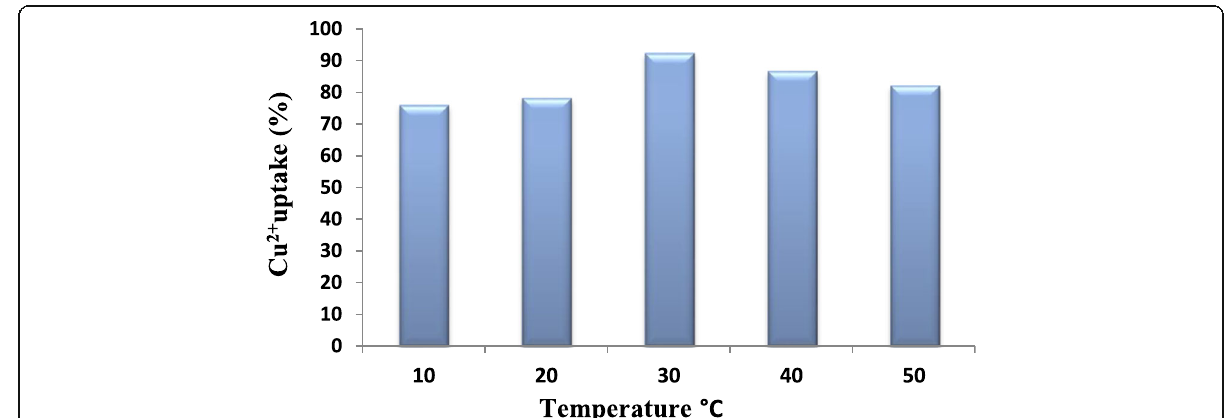
Fig. 4 Effect of temperature °C on Cu 2+ uptake by Aspergillus tamarii NRC 3 biomass (Cu 2+ conc., 80